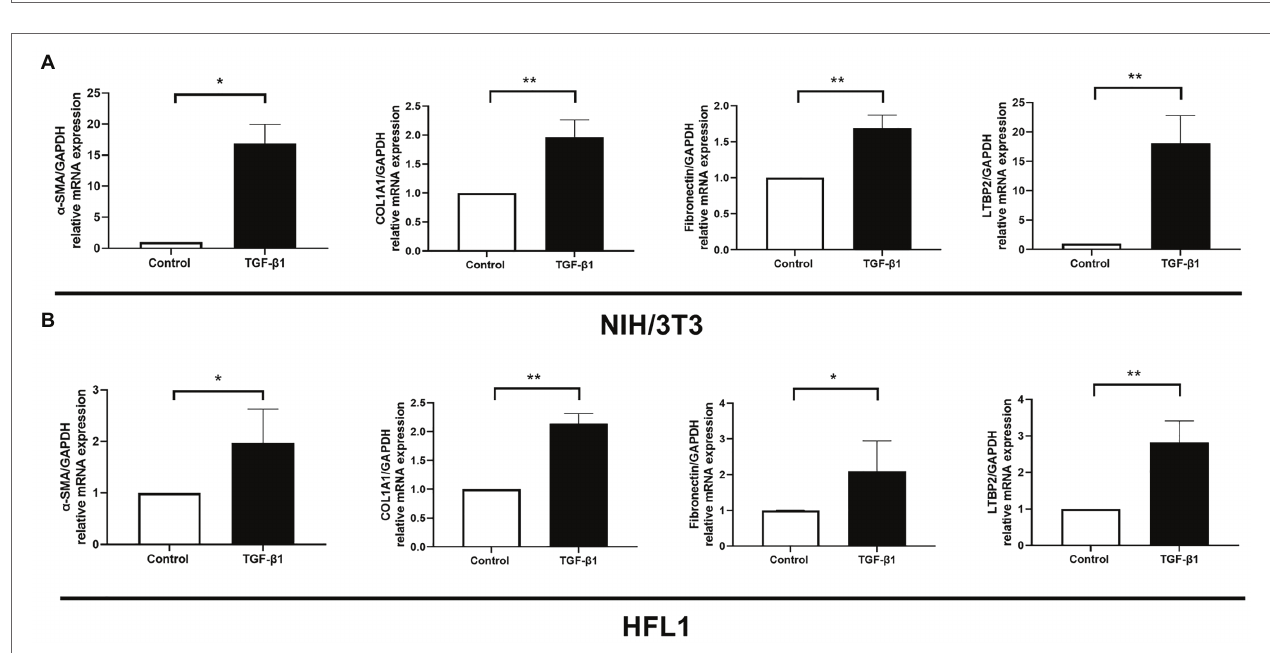
FIGURE 3 | LTBP2 was highly expressed in lungs of mice with PF. (A) Representative images show H&E and Masson’s trichrome staining of lung sections from the indicated groups of mice. Scale bars: 100 μ m. (B) Representative bands of western blots showing expression of COL1A1 and β -tubulin in lungs of indicated mice. (C) Quantitative analysis of hydroxyproline in lung homogenates from indicated mice. (D) Representative bands of western blots showing expression of LTBP2 and β -tubulin in lungs of indicated mice. (E) The mRNA expressions of a-SMA, COL1A1, fibronectin, and LTBP2 in lungs were detected by real-time PCR. (F) Co- immunofluorescence staining for collagen I (green), LTBP2 (red), and DAPI (blue) in bleomycin-treated mice. Original magnification, scale bars: 100 μ m. Data presented as mean ± SD, n = 4–5. * p < 0.05; ** p < 0.01.